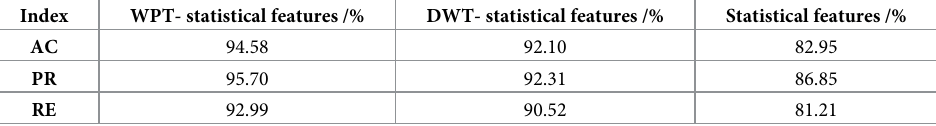
Table 4. Average performance comparison of disturbance recognition algorithms employing different feature extraction